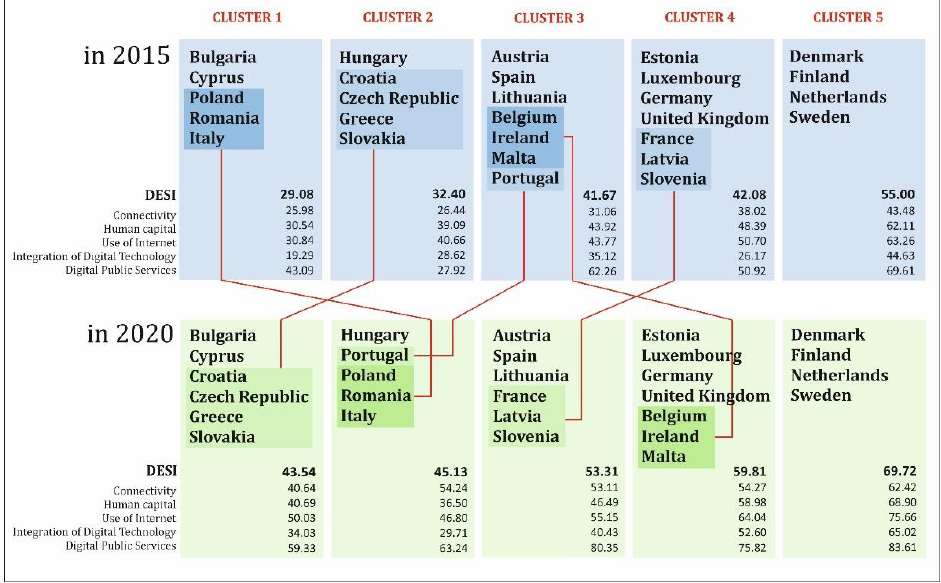
Figure 4. Value of DESI and its subcomponents in a cross-section of isolated clusters. Source: Our own study.